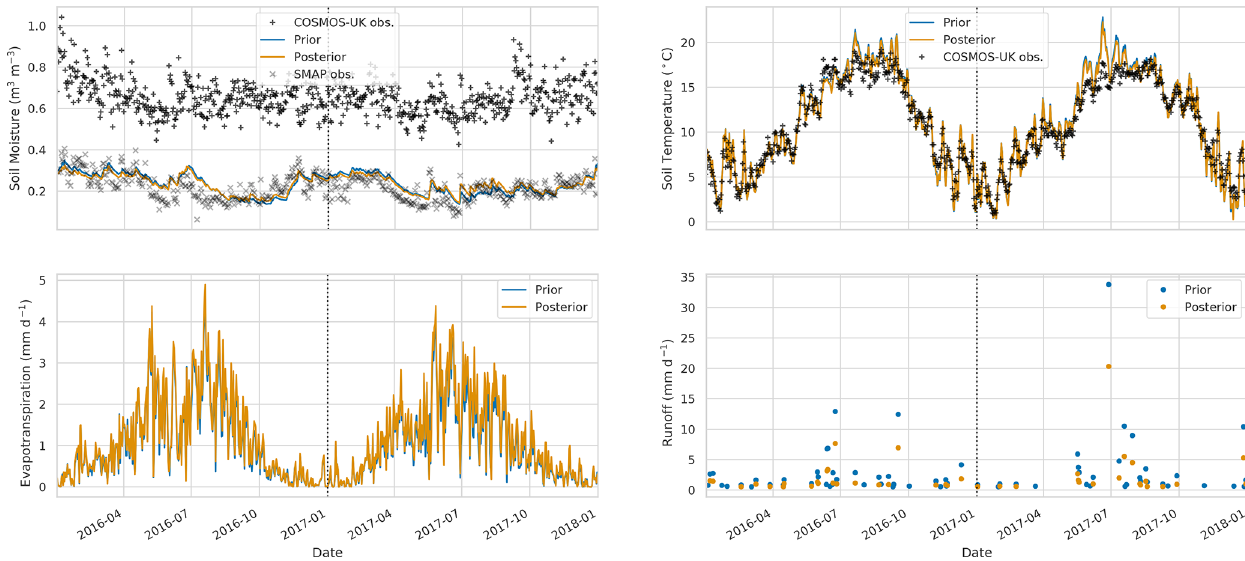
Figure 14. Time series of water budget variables and soil temperature at Redmere COSMOS site. Black plus signs: COSMOS-UK obser- vations, grey crosses: SMAP observations for closest 9km pixel, blue line: prior JULES estimate for closest 1km grid cell, orange line: posterior JULES estimate for closest 1km grid